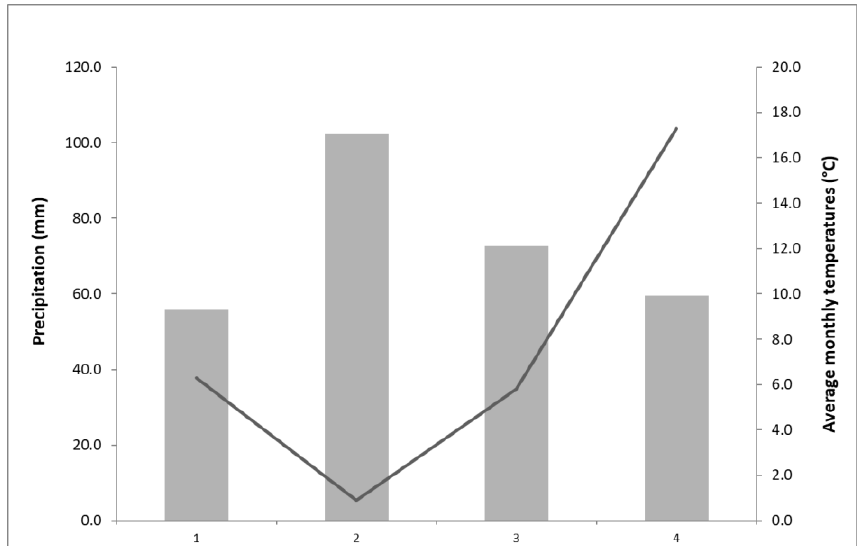
Figure 1. Climate diagram with data from the meteorological station ‘Maksimir’ for the period of January (1) to April (4) (Croatian Meteorological and Hydrological Service, 2019). Columns repre- sent precipitation (mm), while line the average monthly temperatures (°C).